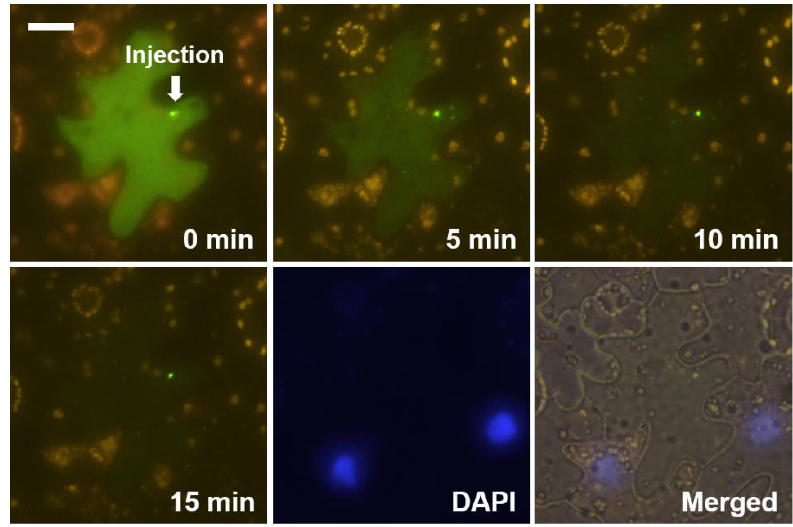
Figure 4. Rapid disappearance of the injected PSTVd (green) observed in some cells without nuclear import: DAPI (blue) shows the nucleus and the scale bar indicates 20 µ m.